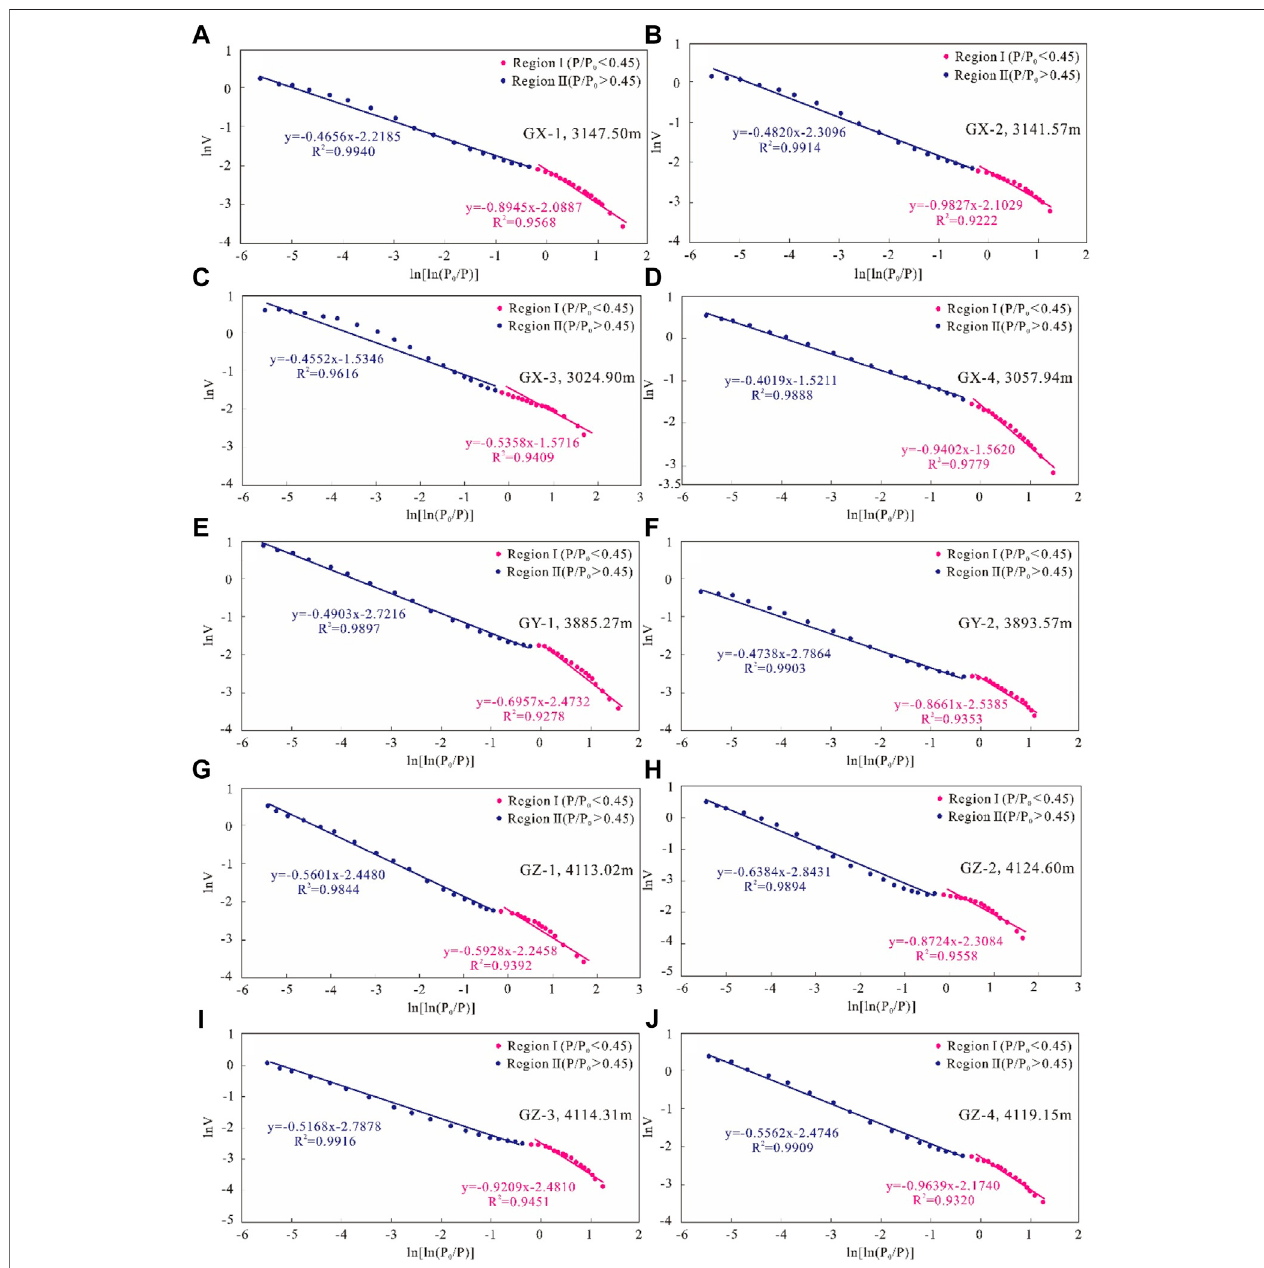
FIGURE 9 | Plots of ln (lnP 0 /P) vs lnV for all 10 shale samples.